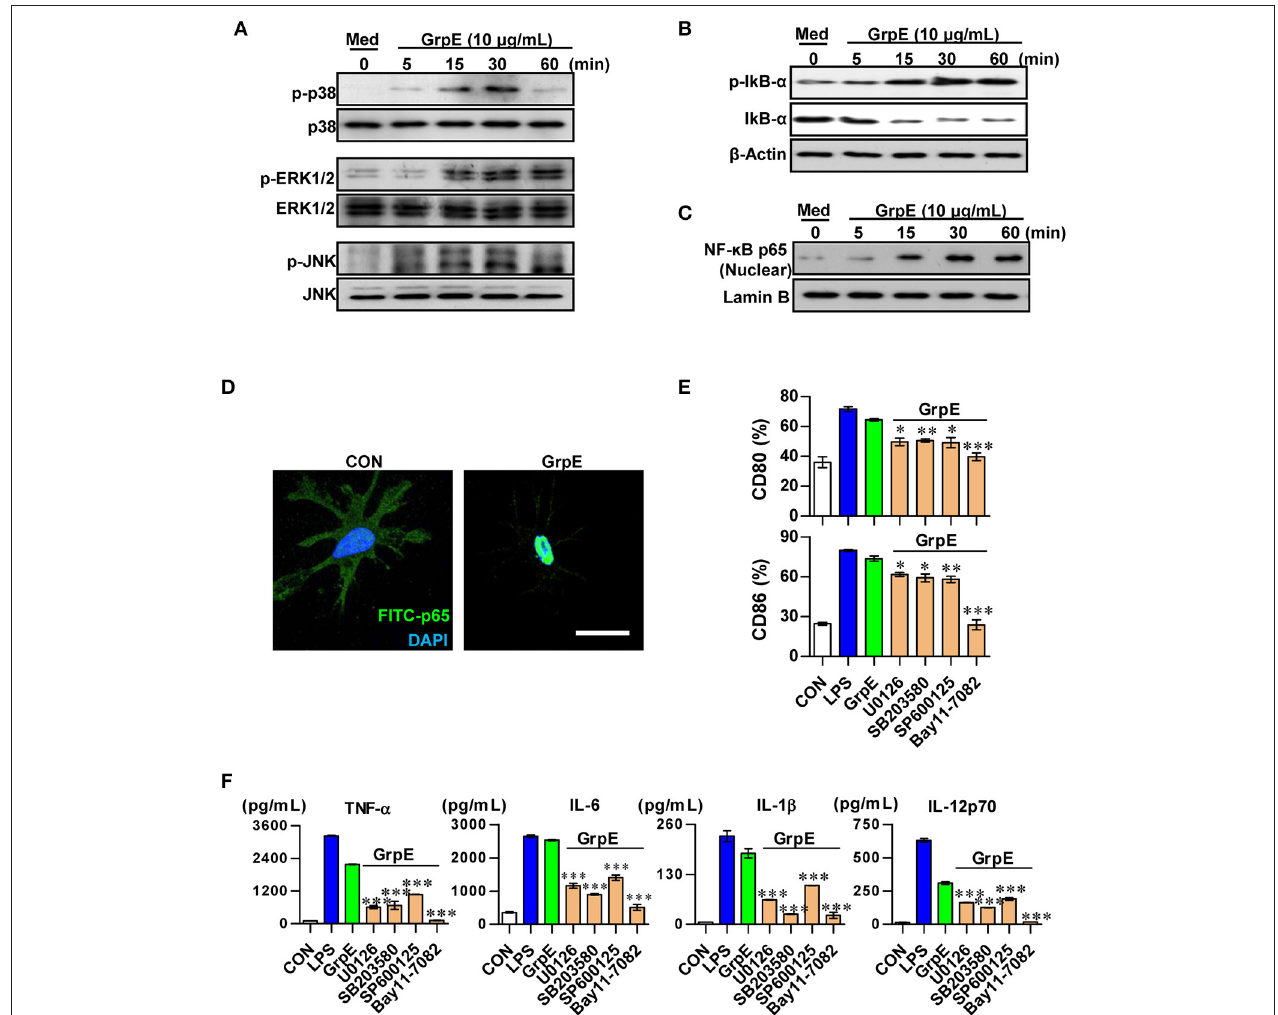
FIGURE 4 | Involvement of the MAPKs and NF- κ B pathways in GrpE-induced DC activation. Western blot analysis of the cytoplasmic fraction (A , B) for phospho-p38 (p-p38), p38, phospho-ERK1/2 (p-ERK1/2), ERK1/2, phospho-JNK (p-JNK), JNK, phosphor-I κ B- α , and p-I κ B- α from whole cell extracts and nuclear fraction (C) p65 NF- κ B. β -actin and Lamin B served as loading controls from cytoplasmic and nuclear fractions, respectively. (D) Immunofluorescence subcellular localization of the p65 protein. Representative results of three independent experiments are shown. (E , F) DCs were pretreated at 37 ◦ C for 1h with the pharmacological inhibitors SB203580 (p38), U0126 (ERK1/2), SP600125 (JNK), Bay 11-0782 (NF- κ B), or dimethylsulfoxide (vehicle control) and then exposed to 10 µ g/mL GrpE for 24h. (E) GrpE and pharmacological inhibitors-treated DCs were stained with anti-CD80 and anti-CD86 and analyzed by flow cytometry. Bar graphs show the percentage for each surface molecule on CD11c + cells. The mean ± SD ( n = 3 samples) of representative of three independent experiments. (F) The amounts of TNF- α , IL-6, IL-1 β , and IL-12p70 in the culture media were measured by ELISA. The mean ± SD ( n = 3 samples) are shown representative of three independent experiments and statistical significance (* p < 0.05, ** p < 0.01, or *** p < 0.001) is shown for treatments compared to GrpE only-treated DCs (Green bars). Con denotes untreated